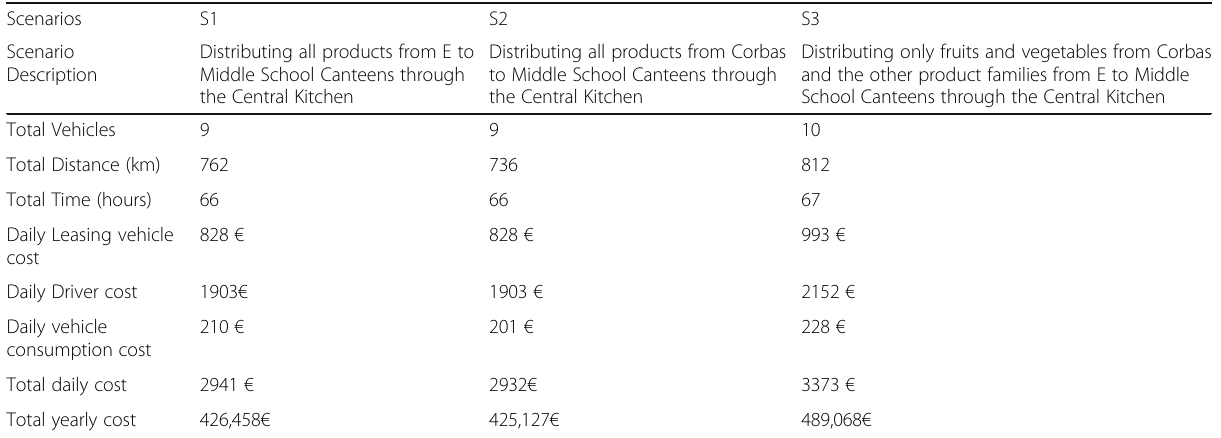
Table 9 The scenarios VRP economic evaluation results for the 3.5 t vehicle calculated by ANNONA Scenarios S1 Scenario